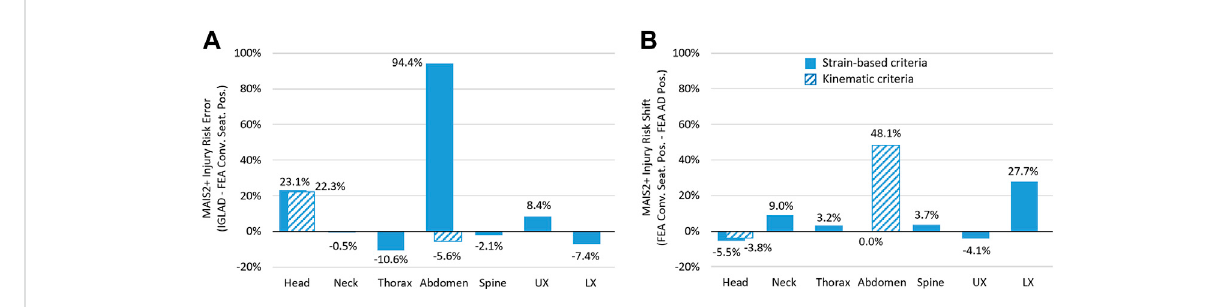
FIGURE 3 (A) Error between injury prediction from HBMand real-world accidentdata. (B) Shiftininjury frequencyas aconsequence ofthelarge rearward adjustments of the seat (using the criteria listed in Table 2).